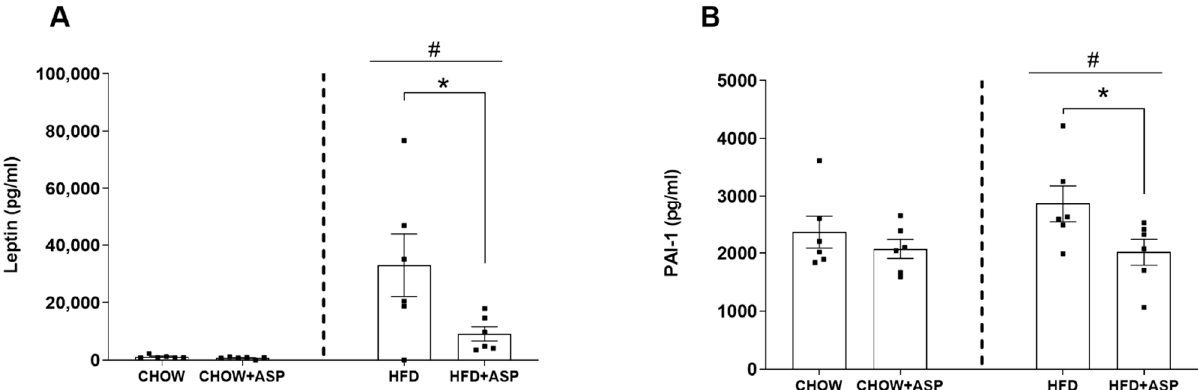
Figure 3. Effect of asperuloside on plasma hormones: ( A ) Leptin; ( B ) Plasminogen activator inhibitor-1 (PAI); n = 6. Standard chow diet (CHOW), high-fat diet (HFD), asperuloside (ASP). Results are expressed as mean ± SEM. Data were analysed by Two-way ANOVA followed by a least significant difference. * Significant ASP effect ( p < 0.05); # Significant overall diet effect [HFD and HFD + ASP] vs. [CHOW and CHOW + ASP] ( p < 0.05).